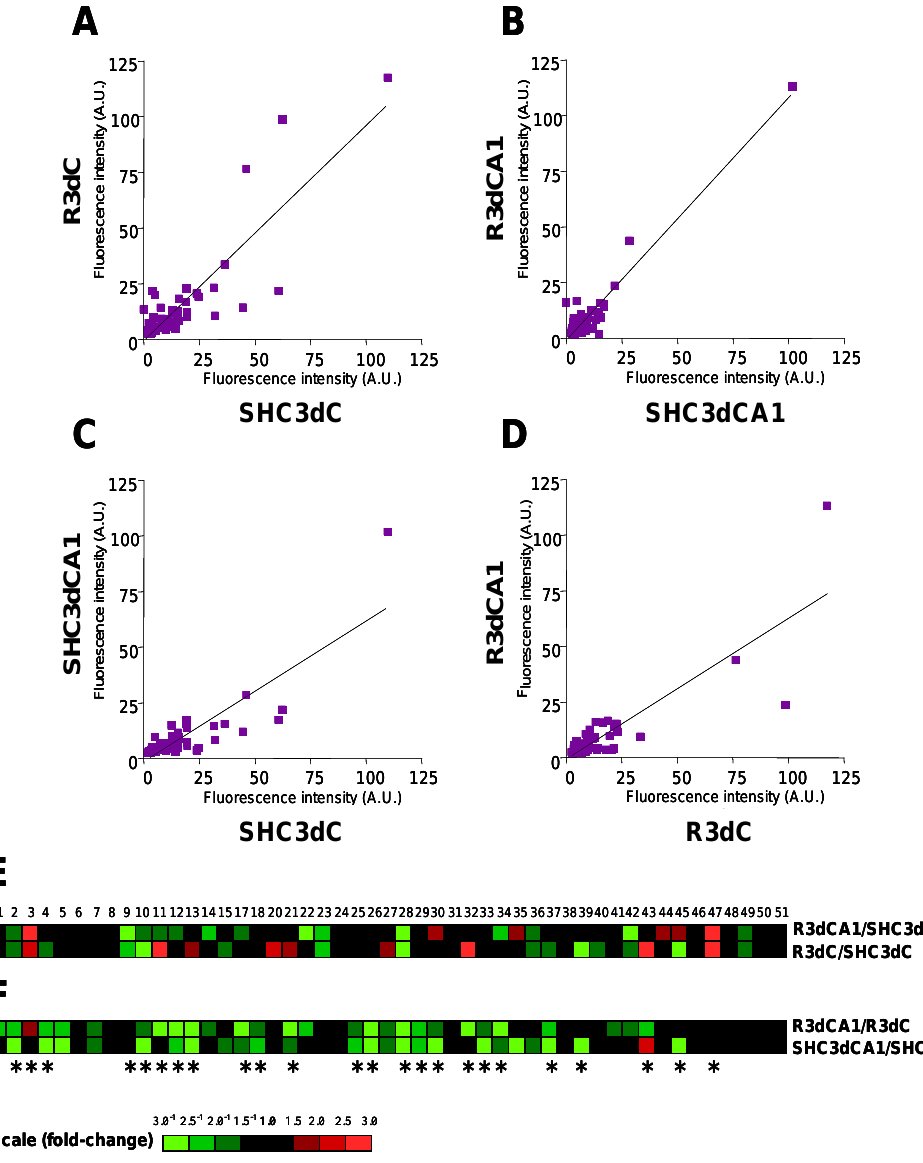
Figure 3. Different brain regions showed a differential association of 4E-BP2-interacting proteins. Scatter plots of the fluorescence intensity of detected proteins in 4E-BP2 immunoprecipitates in ischemia-reperfusion were represented against control condition, in the cerebral cortex (R3dC vs. SHC3dC) ( A ) and CA1 region (R3dCA1 vs. SHC3dCA1) ( B ). Scatter plots of the fluorescence intensity of detected proteins in the CA1 region were also represented against the cerebral cortex in control and IR condition (SHC3dCA1 vs. SHC3dC, and R3dCA1 vs. R3dC) ( C , D ). Fluorescence intensity was quantified in arbitrary units (A.U.). One dot represents the mean of four experiments. The linear regression fitting line, and Spearman correlation p values were < 0.0001. Heat maps of 49 proteins associated to 4E-BP2 were obtained as fold-changes in IR with respect to their control in both CA1 (ratio R3dCA1/SHC3dCA1) and cortical (ratio R3dC/SHC3dC) regions ( E ), and in the CA1 region with respect to the cerebral cortex in IR (ratio R3dCA1/R3dC) and control (ratio SHC3dCA1/SHC3dC) conditions ( F ). Found 4E-BP2-associated proteins were tagged with numbers, and color scale illustrates their fold-change. Differentially associated proteins among the four experimental groups, SHC3dC, SHC3dCA1, R3dC, and R3dCA1, were assessed by ANOVA test (* p <